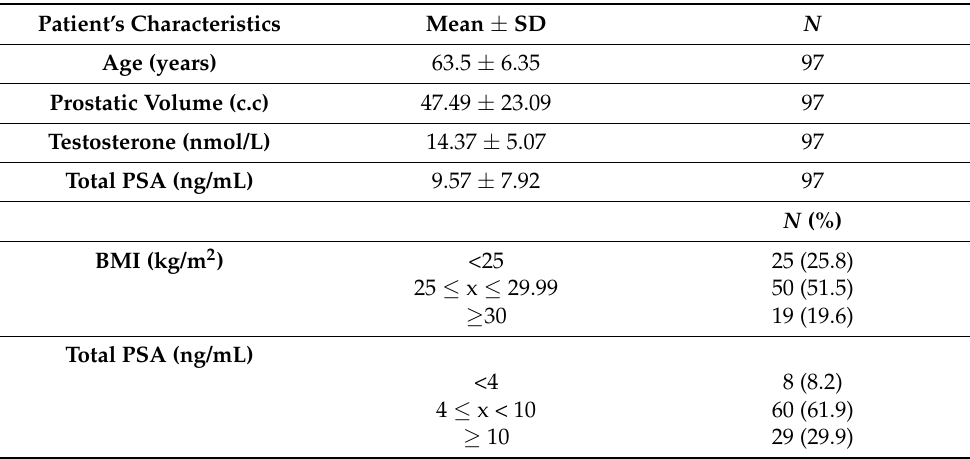
Table 1. Clinical and pathological characteristics of the studied